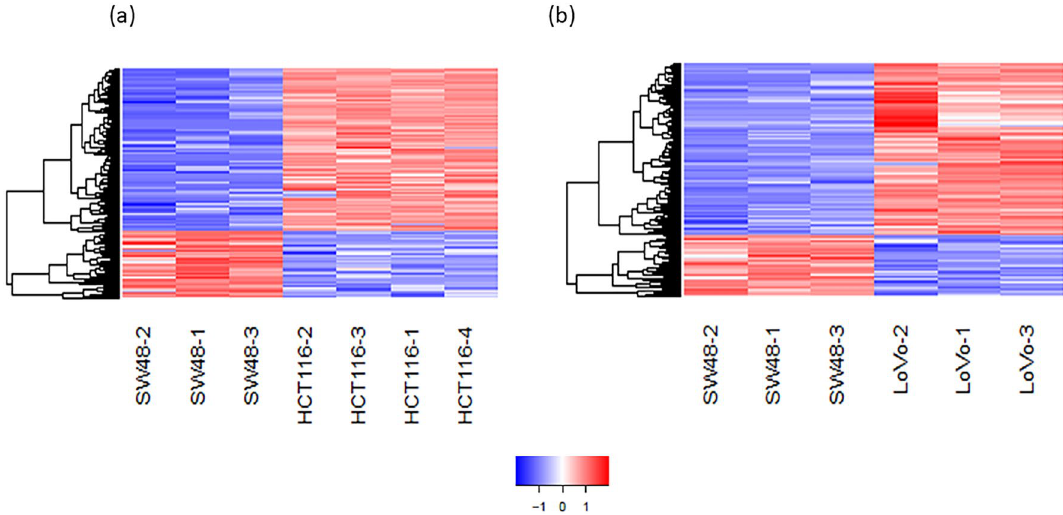
Figure 2. Heatmap plots based on the DEGs showing clustering of mtKRAS and wtKRAS cells lines into two distinct groups based on DEGs. ( a ) Clustering of HCT-116 and SW48 samples. ( b ) Clustering of LoVo and SW48 samples. Red shows overexpression and blue indicates underexpression with absolute log2FC > 1.5 and adjusted p-value < 0.05. Expression data are represented as normalized values (Z-scores). Heatmap plot was created using gplots package in R environment and variance stabilizing transformation (VST) was applied to the normalized count data from DESeq2